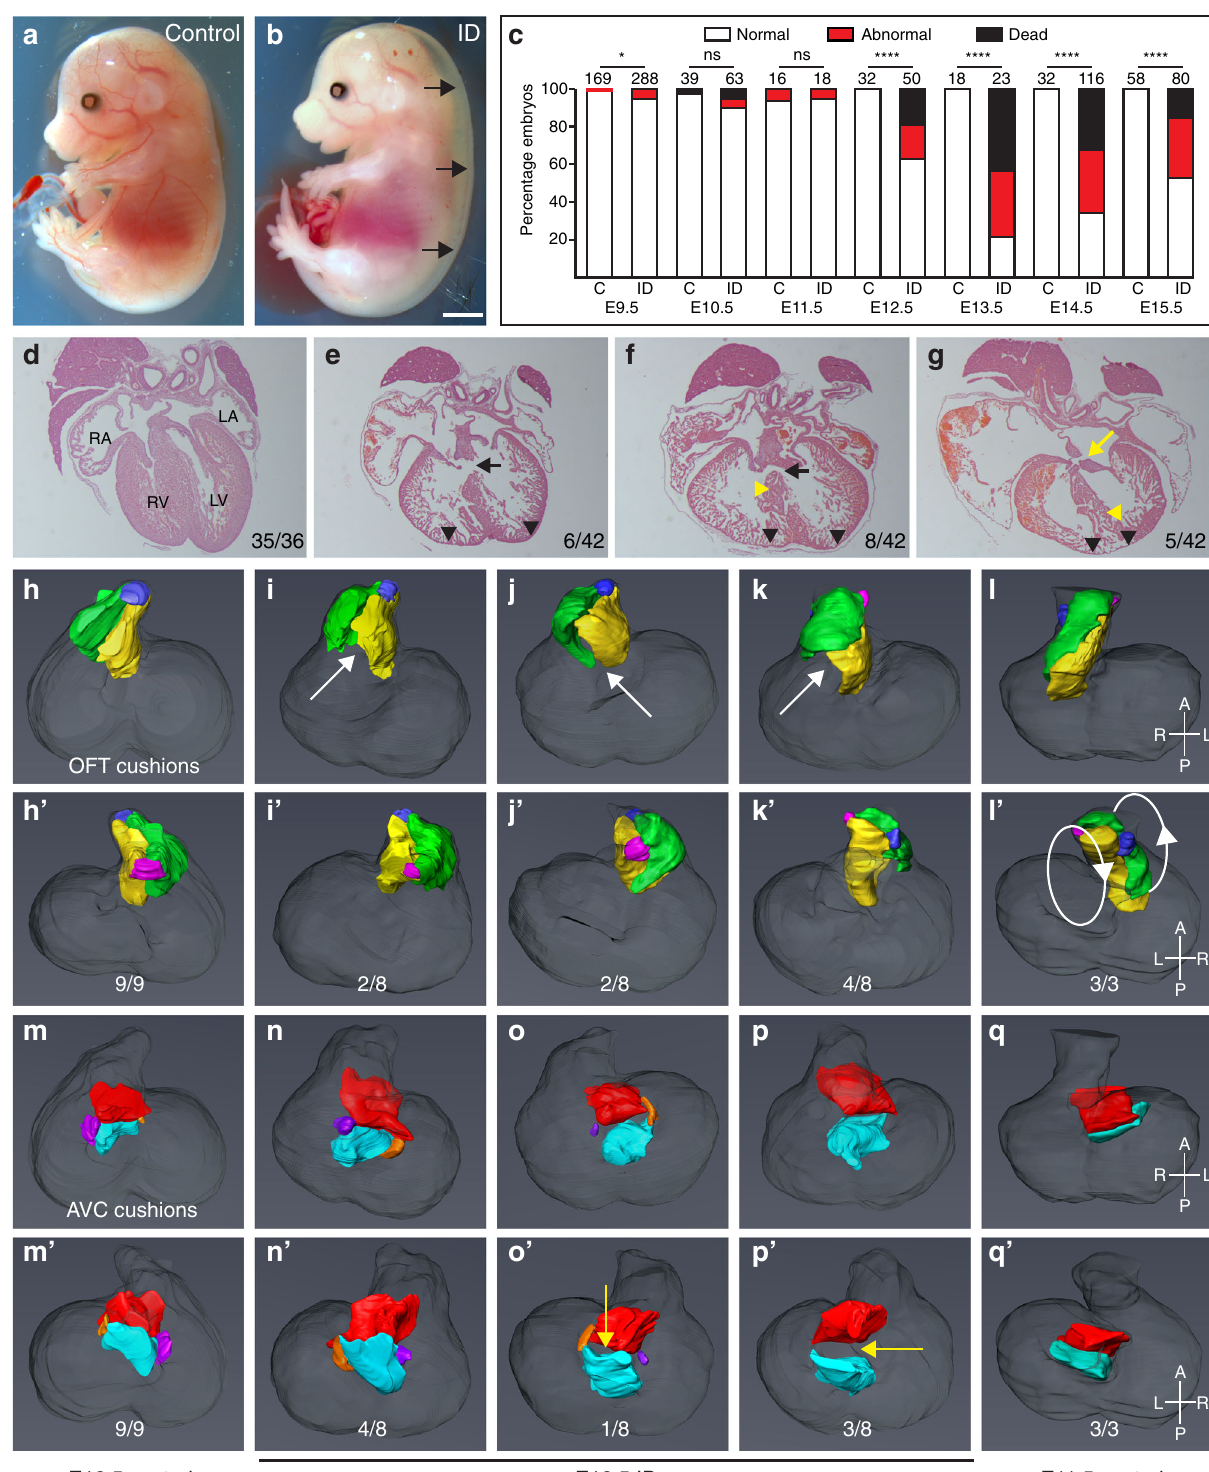
fi eld (SHF) cardiac progenitor cells to the OFT, including Tbx1 , Hes1 and Hoxb1 null embryos, and embryos exposed to hypoxia in utero 5,14 – 16 . In these studies, reduced OFT length is proposed to cause malrotation and malalignment of the OFT at later developmental stages. In keeping with this hypothesis, by E12.5 4/ 8 ID embryos had a non-rotated OFT based on cardiac cushion position (Fig. 1k), 2/8 were partially rotated (Fig. 1j) whilst 2/8 were normal (Fig. 1i), compared to 9/9 control embryos with